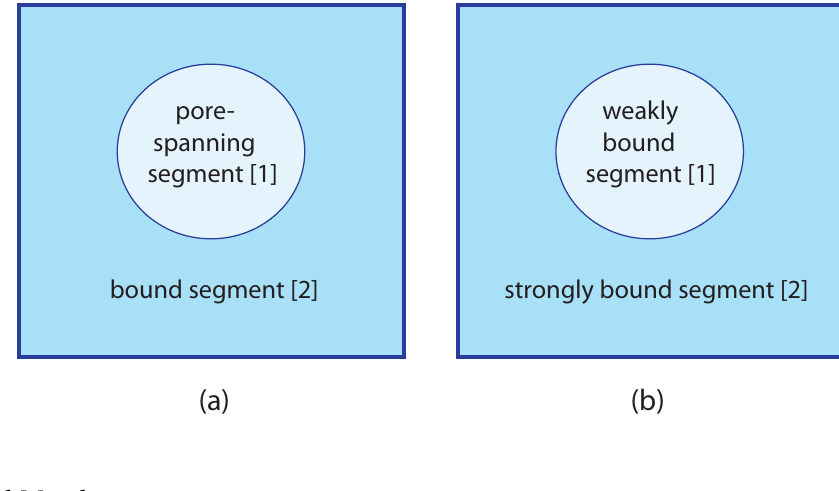
Figure 3. ( a ) Top view of a partially supported membrane spanning a single circular hole or pore within the rigid support. The membrane consists of a pore-spanning or unbound segment S [1] with area A [1] and a bound segment S [2] with area A [2] ; and ( b ) Membrane supported by a chemically patterned surface with a single, circular surface domain that attracts the membrane less strongly than the surrounding substrate. The membrane is then divided up into a weakly bound segment S [1] with area A [1] and a strongly bound segment S [2] with area A [2] . If the circular surface domain does not attract or repel the membrane, the adhesion geometry in ( b ) is thermodynamically equivalent to the one in ( a